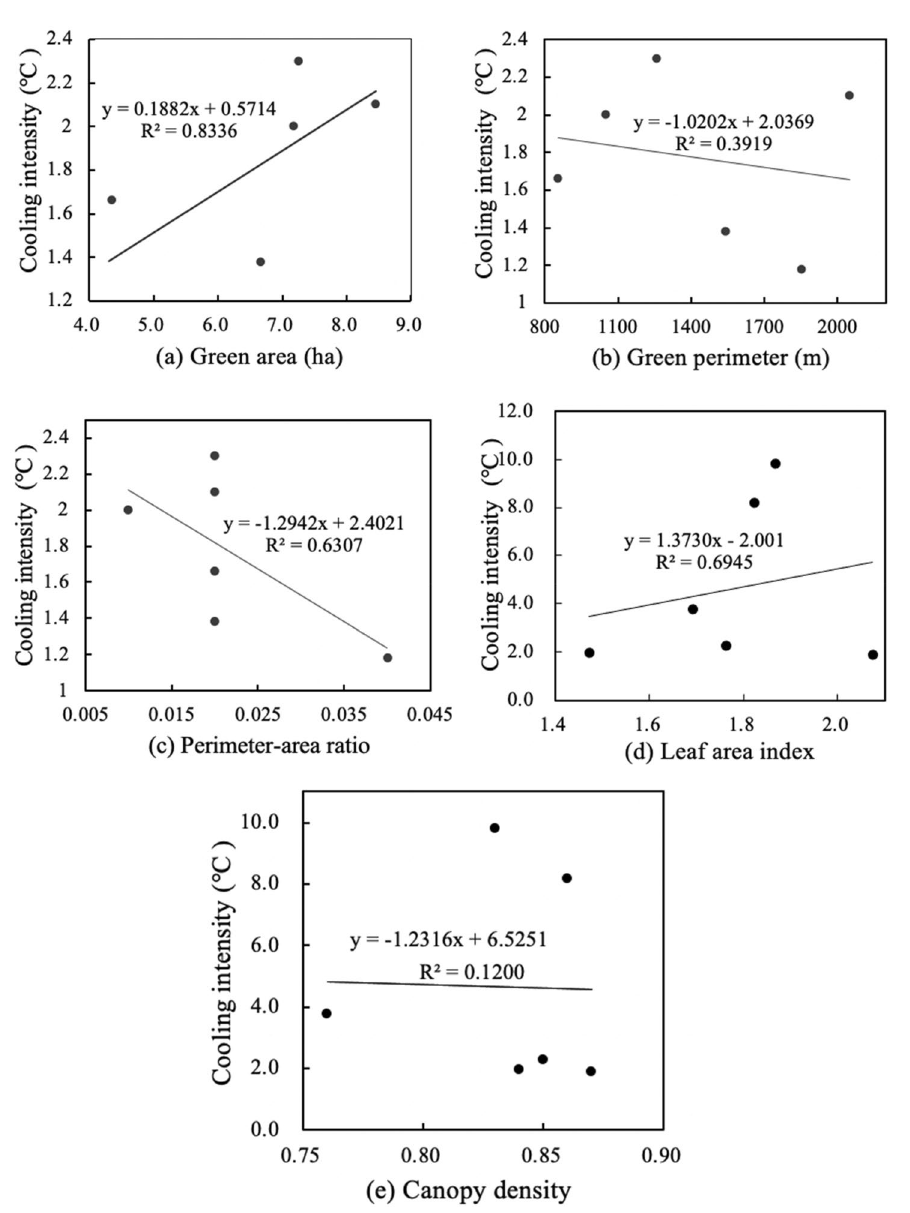
Figure 7. Linear regressions between spatial characteristics and cooling intensity of medium-size green